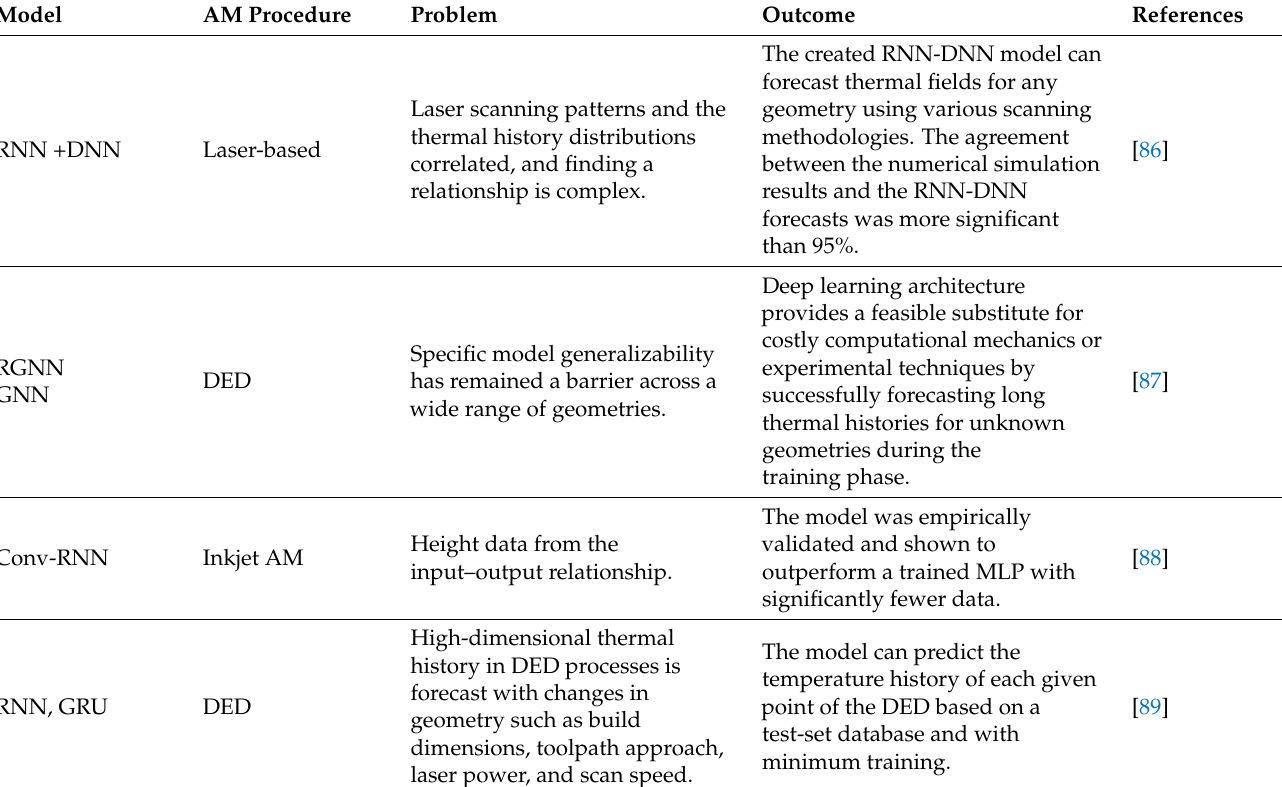
Table 5. Summary of various literature on sequences